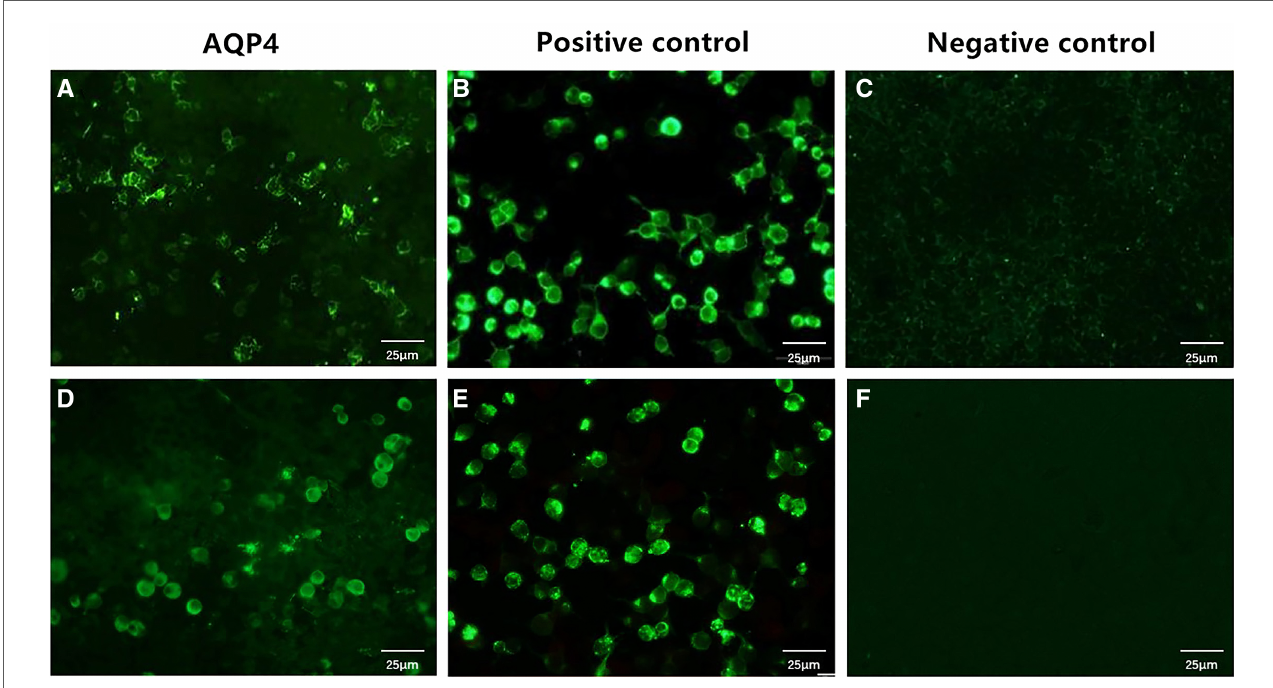
FIGURE 2 Serum anti-AQP4 – IgG levels in the patient. The serum samples of the patient were examined using cell-based assays, which used HEK293 cells transfected with human AQP4. The anti-AQP4 antibody test is positive ( A ), and the antibody titer is 1:10 (initial titer, 1:1). After 3 days, the anti-AQP4 antibody test is still positive, with an antibody titer of 1:10 ( D ). ( B,E ) are positive controls, while ( C,F ) are negative controls. Cells stained green are positive for the anti-AQP4 antibody; unstained cells are negative for this antibody. Scale bar: 25 μ m. AQP4,